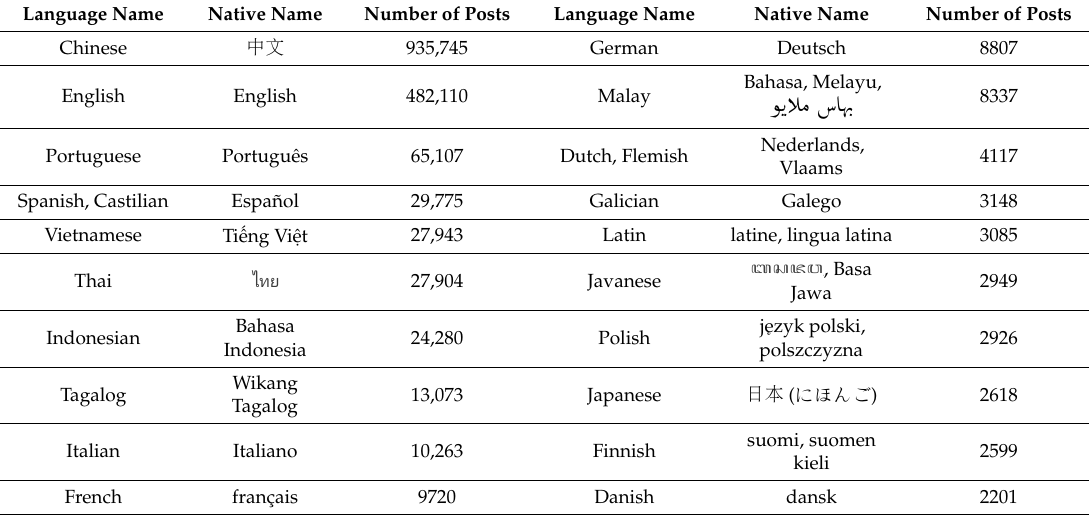
Table 2. Top 20 languages analyzed in the posts data.